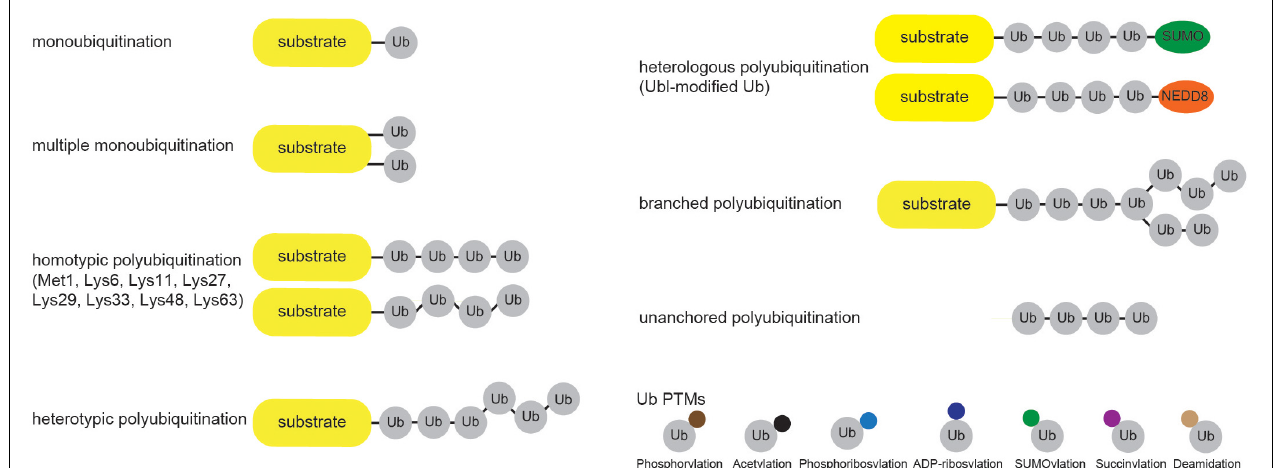
FIGURE 2 | Cellular ubiquitin modification comes in different formats. Single Ub moieties can modify proteins at one (monoubiquitination) or several (multiple monoubiquitination) Lys residues. Ub can form eight distinctive homotypic linkages, either through Met1 (linear Ub chain) or 7 internal Lys residues (Lys6-, Lys11-, Lys27-, Lys29-, Lys33-, Lys48-, and Lys63-linked Ub chains). Additional complexity is achieved through the formation of heterotypic Ub chains, which contain multiple Ub linkages and adopt mixed or branched topology. Furthermore, heterologous polymers contain additional UBLs, such as SUMO or NEDD8, within Ub chains. Ub molecules undergo various PTMs, including phosphorylation and acetylation, which regulate their binding properties and abilities to generate Ub